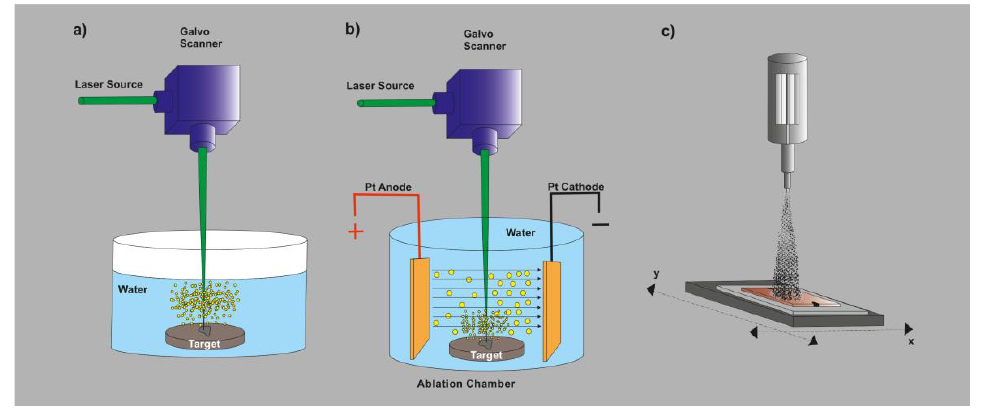
Figure 13. Schematic of LAL ( a ) and EFLAL setups ( b ); ultrasonic atomizer setup ( c ).